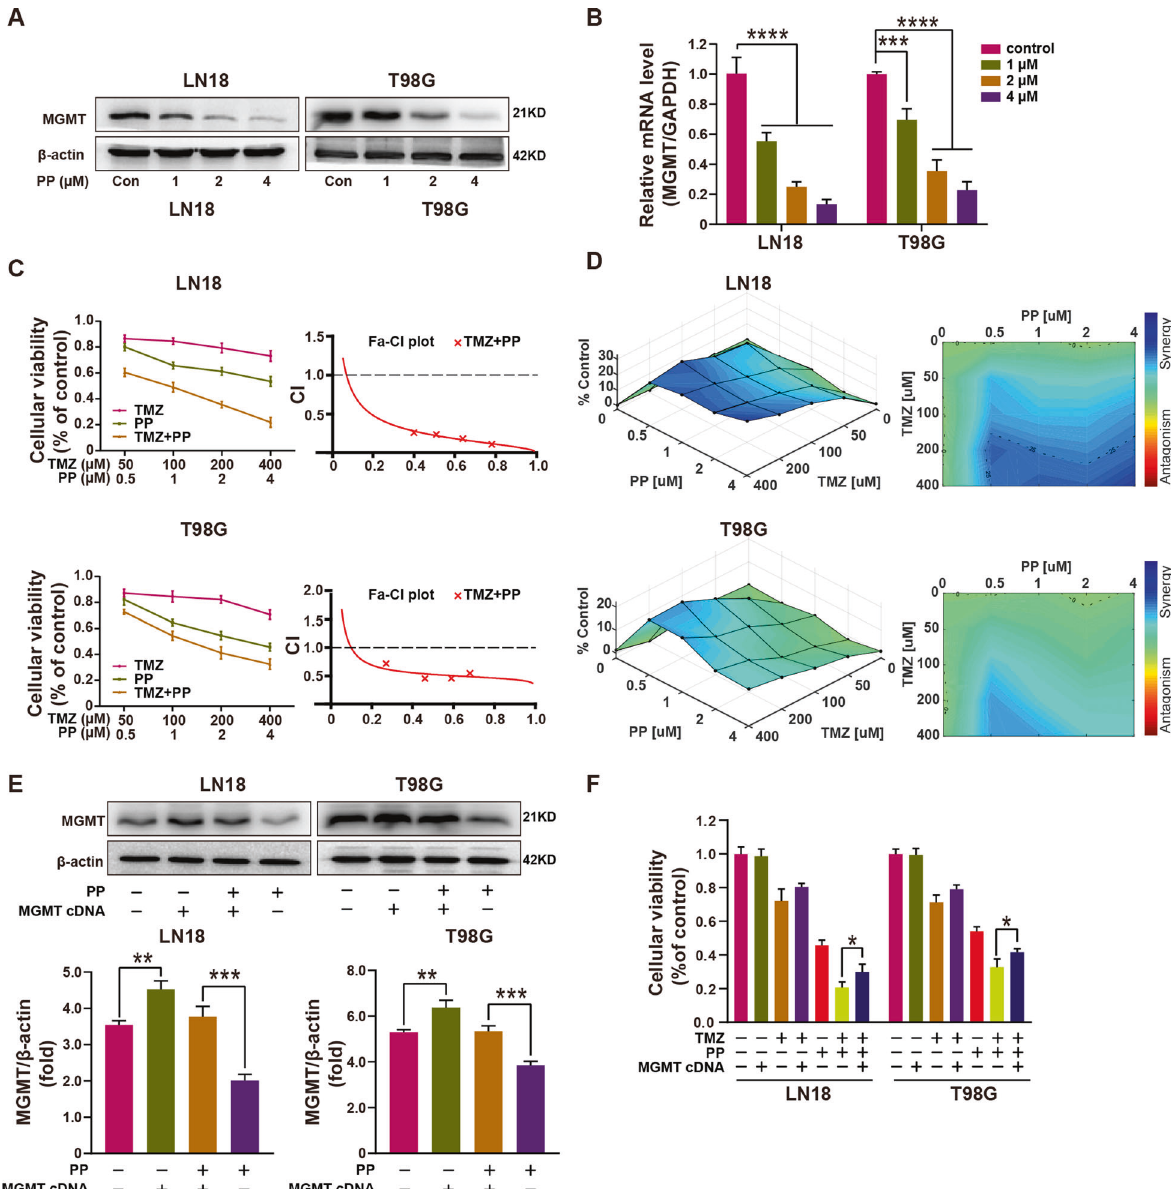
Fig. 3 PP down-regulated MGMT expression and enhanced the TMZ chemotherapeutic effect on GBM cell lines. A The PP role in MGMT protein level was measured through western blotting. B The PP role in MGMT mRNA level was measured through quantitative RT-PCR ( n = 3). C LN18 and T98G cell viability under PP and TMZ treatment at different contents ( n = 3). CalcuSyn 2.0 was adopted to generate the curves. The Fa-CI plots showed the value of combination index (CI) in every fractional effect, and PP was synergized with TMZ (CI < 1). D Surface plots of LN18 and T98G cells treated with TMZ, PP, or combined TMZ + PP shown in 2D and 3D. Plots were generated using Combene fi t program by applying HSA model. E MGMT protein levels in over-expressing MGMT and control cells were examined within LN18 and T98G cells (top panel). Densitometric analysis of MGMT/ β -actin expression fold change (bottom panel) ( n = 3). F Effect o f MGMT overexpression on cell viability under TMZ, PP, or TMZ combined PP treatment ( n = 3). Results were presented in the manner of mean ± SD. * p < 0.05; ** p < 0.01; *** p < 0.005; **** p <